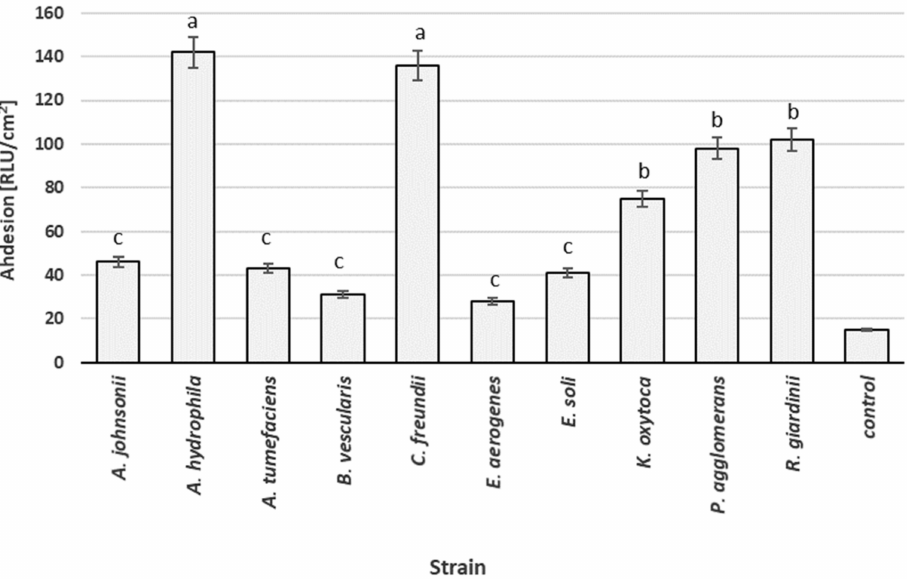
Figure 5. Adhesion of bacterial isolates to a glass surface after 6 days of